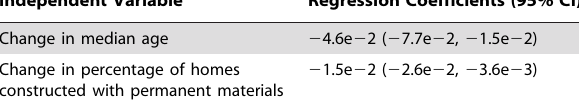
Figure 5. Period of multiannual oscillations of DHF incidence in eachofthe72provincesofThailand. Eachlineis the periodinmonths of the incidence in one province. Period presented is the mean period of powerina periodbandof 18to60 moreconstructed usingthecontinuous wavelettransform (see Text S1,DetailedMethods). The thickline showsthe period of multiannual oscillations of country-wide incidence.